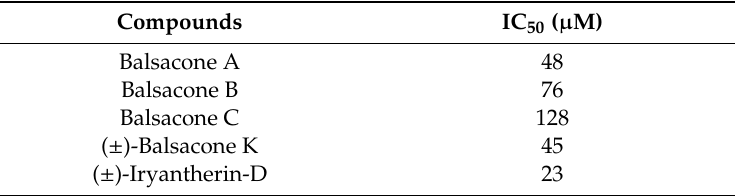
Table 1. Anti-proliferative property of dihydrochalcone derivatives.